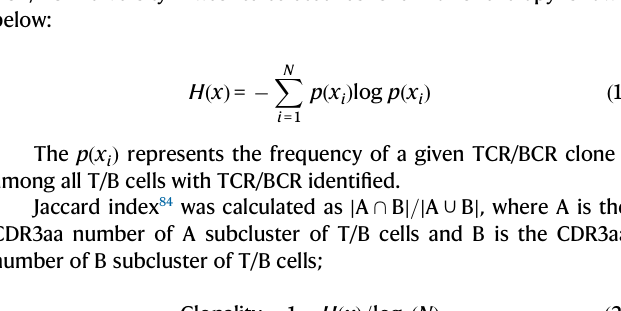
Fig. 7 | Prognostic value of ISG15 + CD8 + T cells. a Representative fl ow cytometric plots showing the gating strategies for ISG15 + B cells, and CD4 + and CD8 + T cells. MouseCD3 + Tcellswereused asthenegativecontrols. b Scatterplotsshowingthe frequencies of ISG15 + %B, ISG15 + %CD4, ISG15 + %CD8, MX1 + %B, MX1 + %CD4, and MX1 + %CD8 cells from the indicated groups. The number of each group is indicated in parentheses. Data are presented as mean±SD and the error bars denote SD. Sta- tistical signi fi cance is calculated using the two-tailed Mann – Whitney